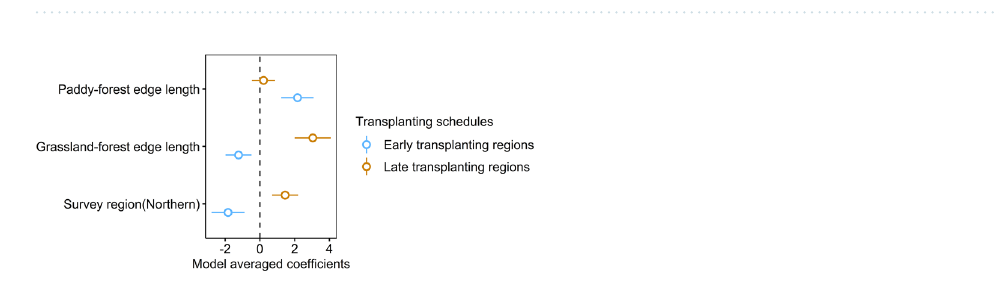
Figure 4. The relationship between breeding buzzards and grassland-forest edge length. Blue dots represent the data in early transplanting regions and yellow dots represent the data in late transplanting regions. The solid lines represent the regression curve estimated from the smallest AIC model including interaction term and the dotted lines represent the 95% credible interval.